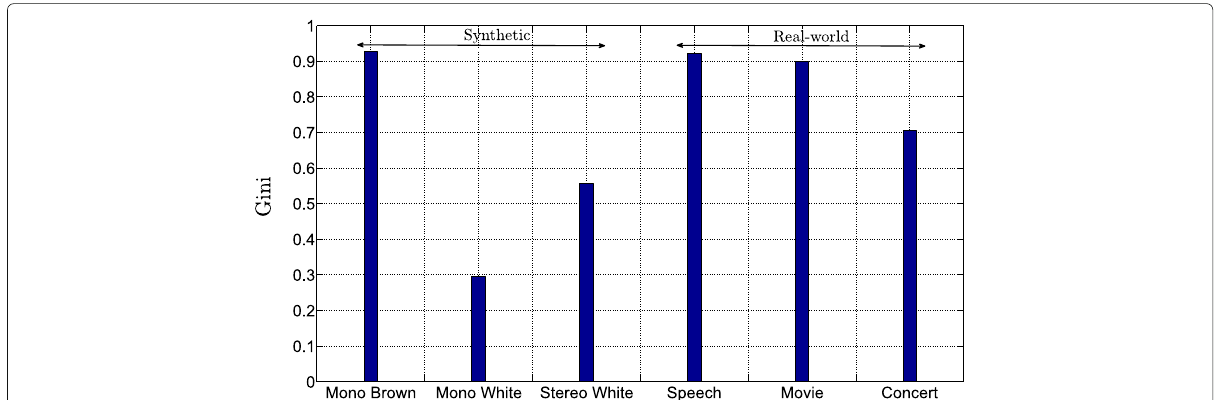
Fig. 6 Gini indices for joint spectro-spatio-temporal sparsity for different reference